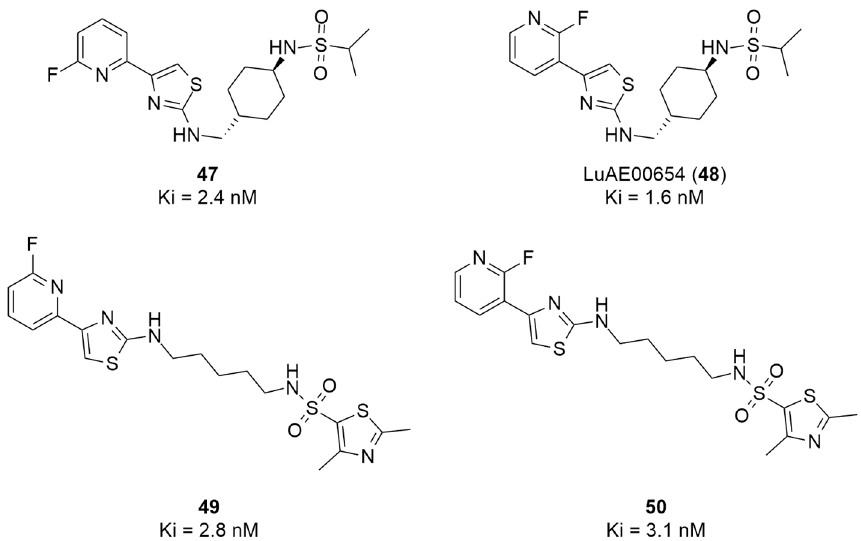
Figure 14. Selected candidate PET ligands for the Y 5 receptor.